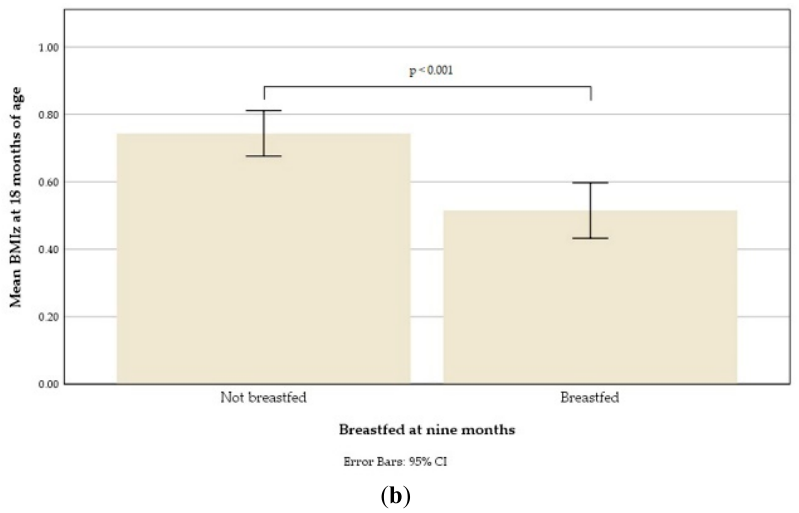
Figure 7. Breastfeeding at nine months of age: ( a ) Distribution; ( b ) An error bar displaying the mean body-mass index z -score (BMIz) at 18 months of the not breastfed and the breastfed children at nine months of age.